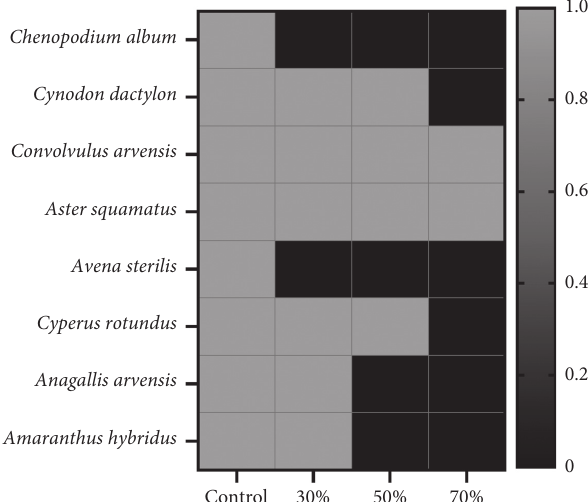
Figure 3: Weeds present in the different shaded areas (control, 30%, 50%, and